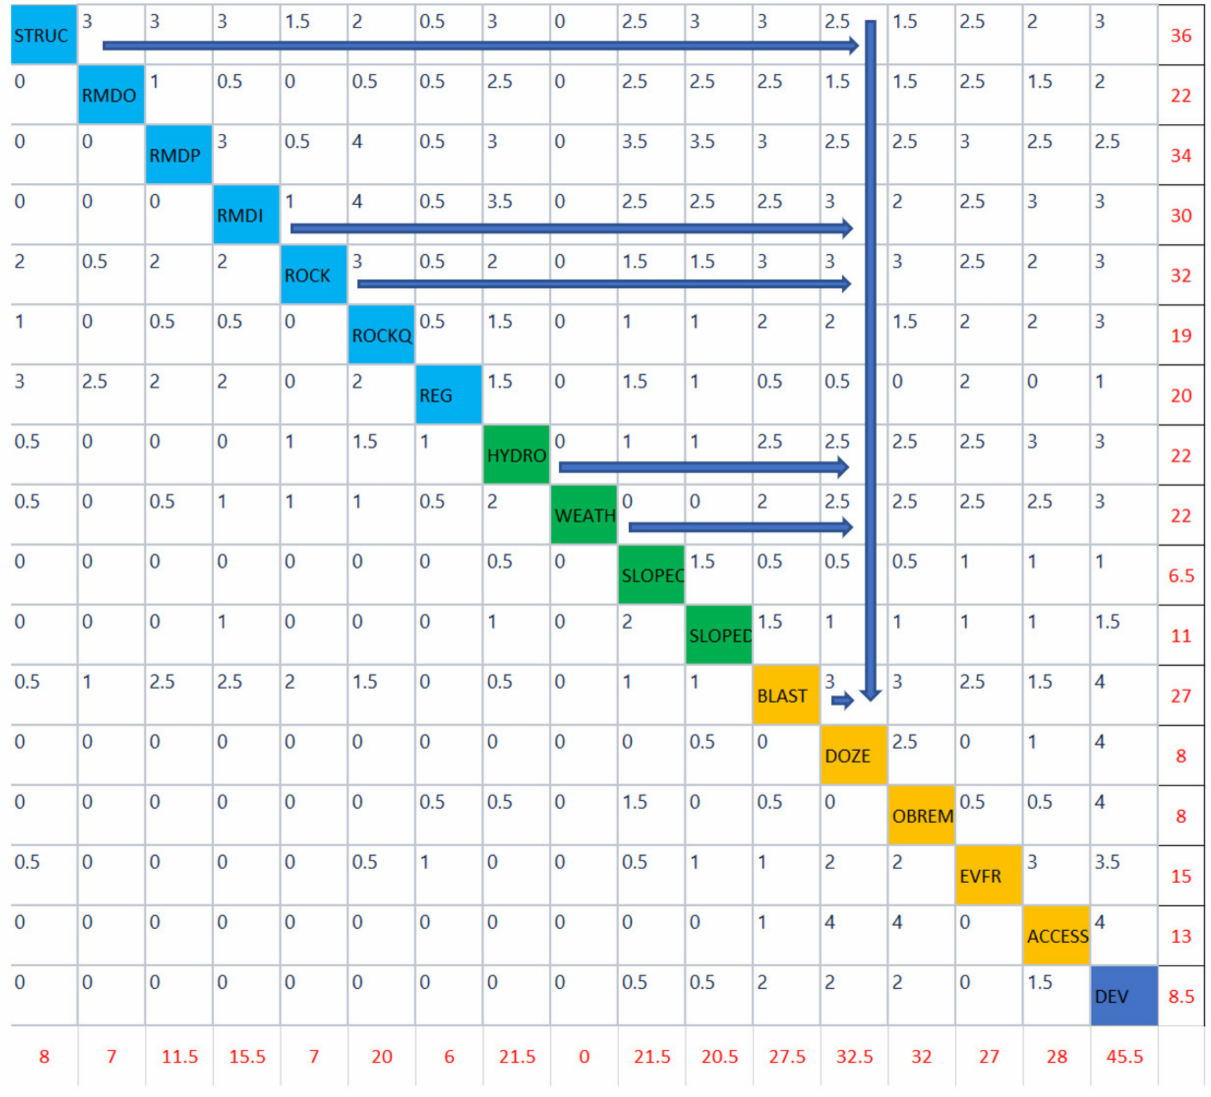
Figure 7. BIM matrix after scoring. For example, that structure, RMDI, rock type, hydrogeology, weather, and blast have strong interactions with dozer operation’s